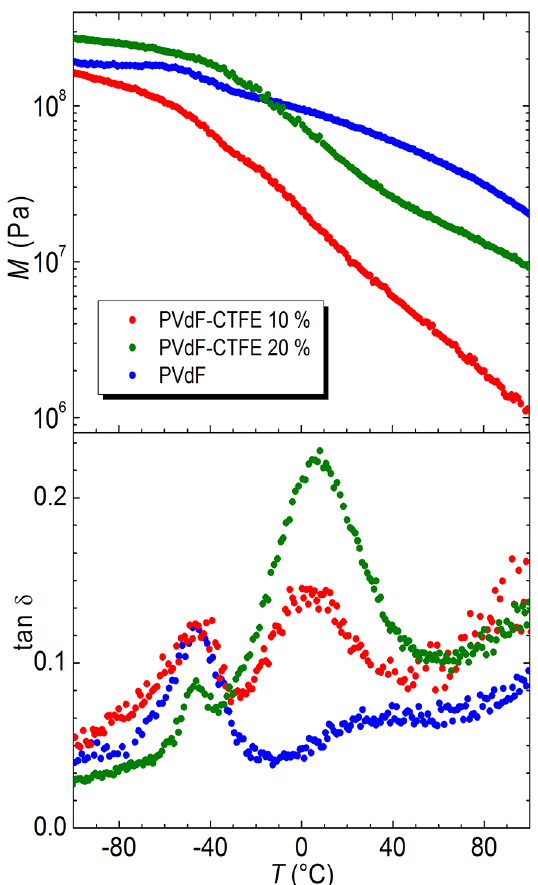
Figure 2. Temperature dependence of the tensile modulus (upper part) and of the elastic energy dissipation (lower part) measured at 10 Hz on heating from -100 °C up to 100